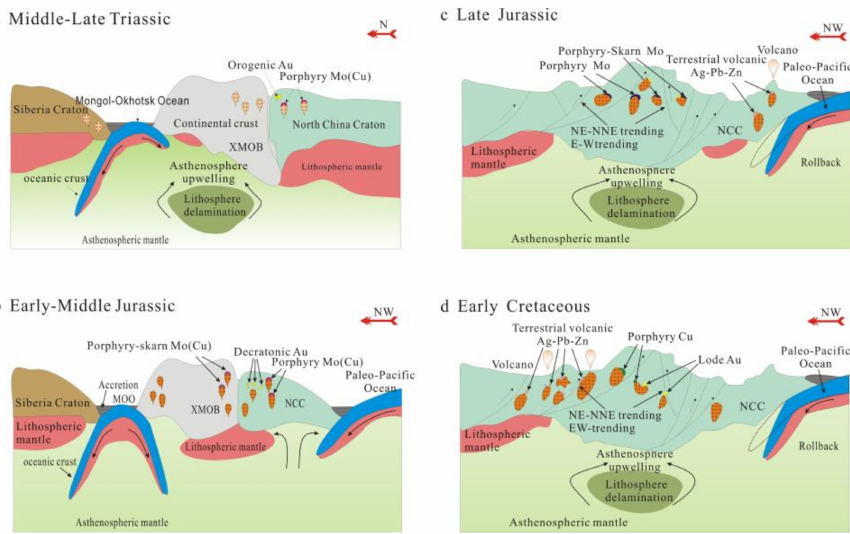
Figure 11. Schematic illustration of a genetic model for the mineralization in the northern flank of the NCC during Mesozoic (modified from [96,111]). ( a ) Middle–Late Triassic (240–205 Ma); ( b ) Early– Middle Jurassic (190–160 Ma); ( c ) Late Jurassic (155–135 Ma); ( d ) Early Cretaceous (135–100 Ma). XMOB, Xing’an-Mongolia Orogenic Belt; NCC, North China Craton; MOO, Mongol-Okhotsk